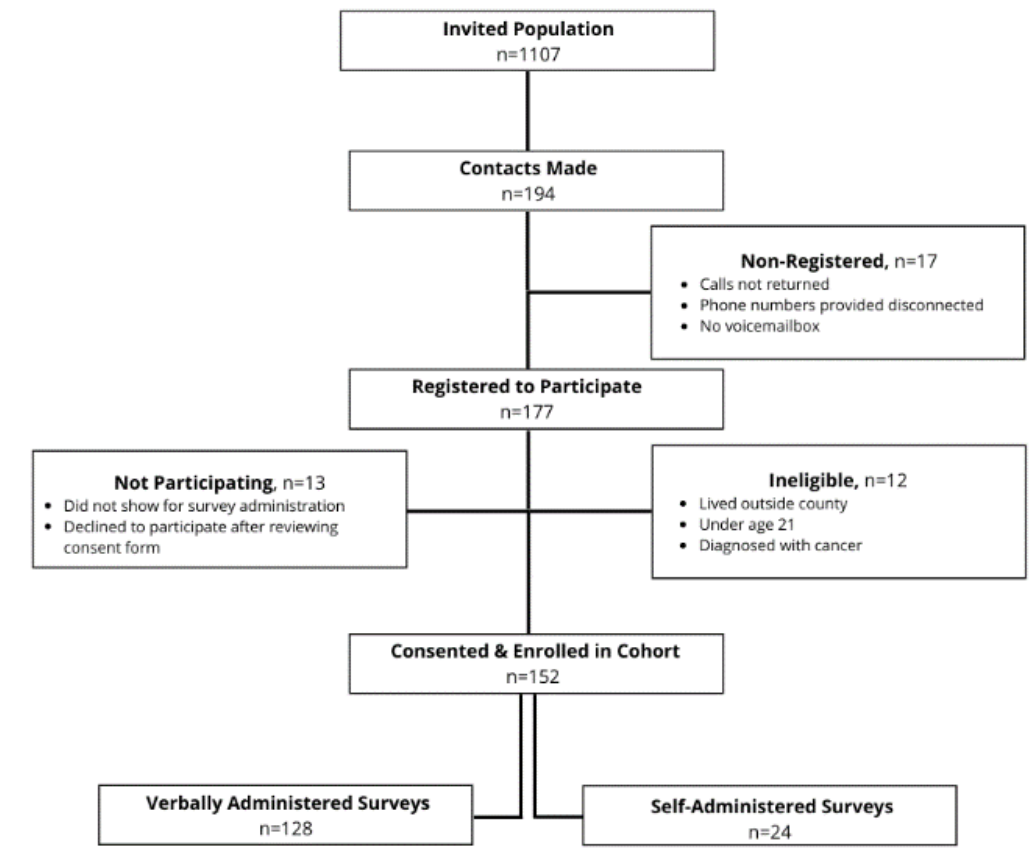
Figure 2. Prospective Cohort Recruitment Processes.